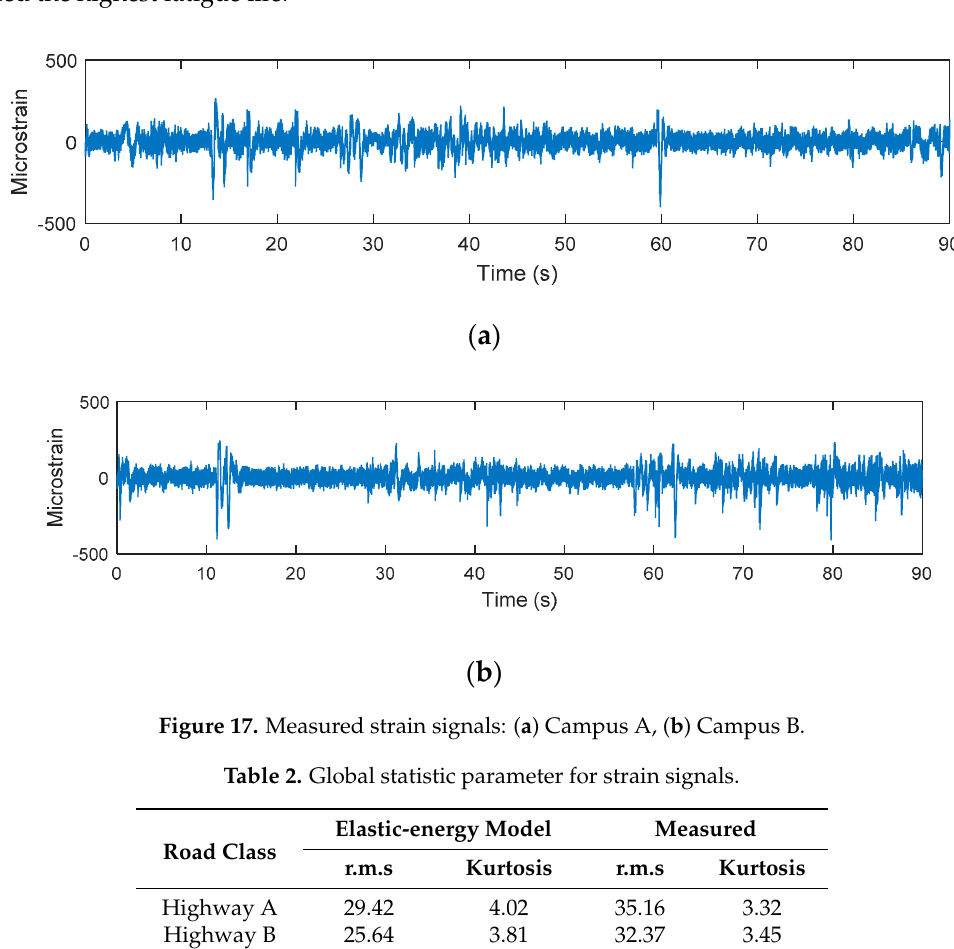
Figure 16. Elastic-energy strain signals: ( a ) Campus A, ( b ) Campus B.